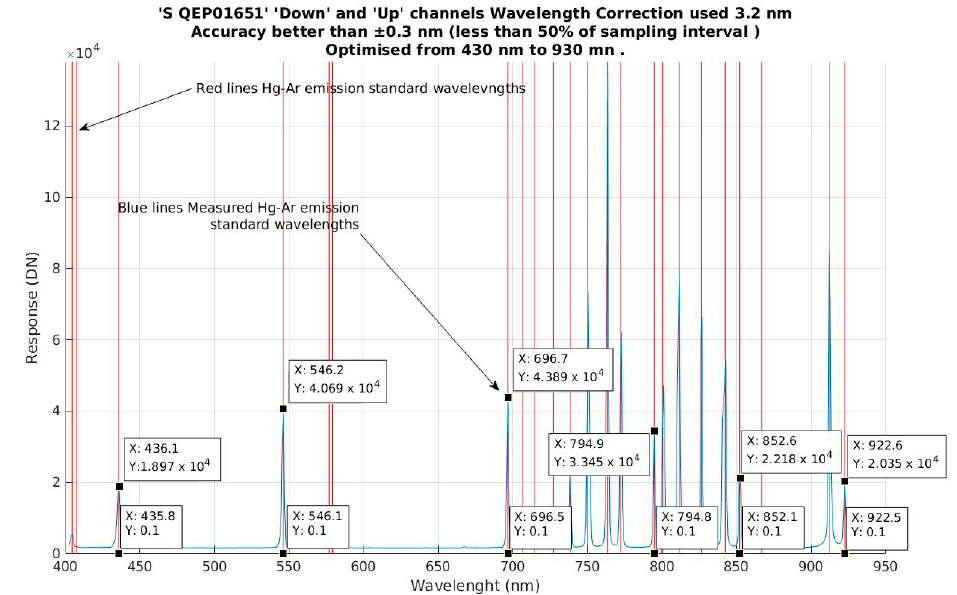
Figure 3. Report on Piccolo system calibration for QEPro 01651 as an example provided by Piccolo system suppliers. Remote Sens. 2018 , 10 , x FOR PEER REVIEW